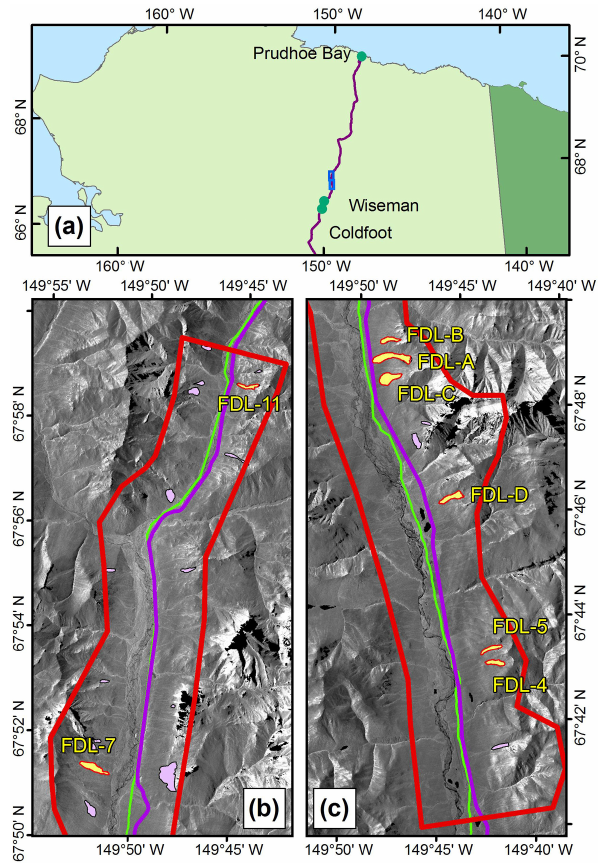
Figure 1. Map of the study area. (a) Location relative to communi- ties along the Dalton Highway (shown in purple); blue rectangular insets show locations of area of interest (AOI). The northern and southern portions of the AOI (in red) are shown in (b) and (c) , re- spectively. The eight investigated FDLs are shown in yellow and la- beled; other FDLs within the AOI are shown in lavender. The TAPS alignment is indicated in green; within the AOI the infrastructure parallels the Dietrich River. (Base map data from ASGDC, 2014 and GINA,